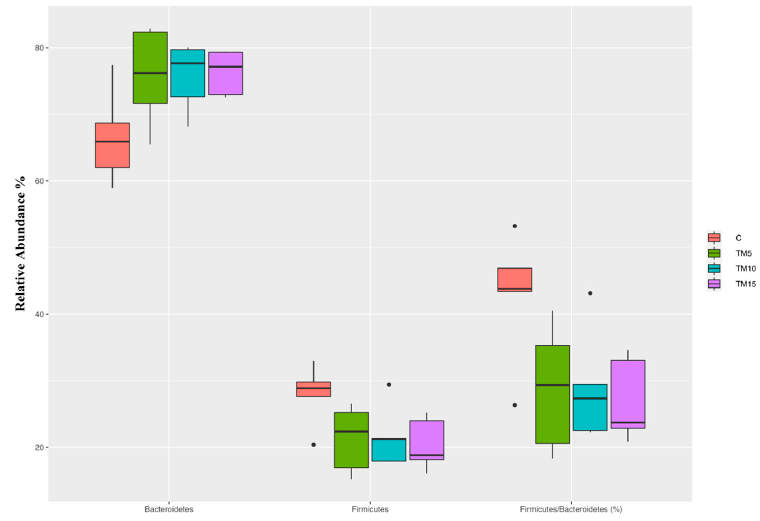
Figure 3. Phyla changes (FDR <0.05) in cecal samples of heavy-size broiler chickens fed control (C), 5% (TM5), 10% (TM10) and 15% (TM15) inclusion level of Tenebrio molitor meal diets.